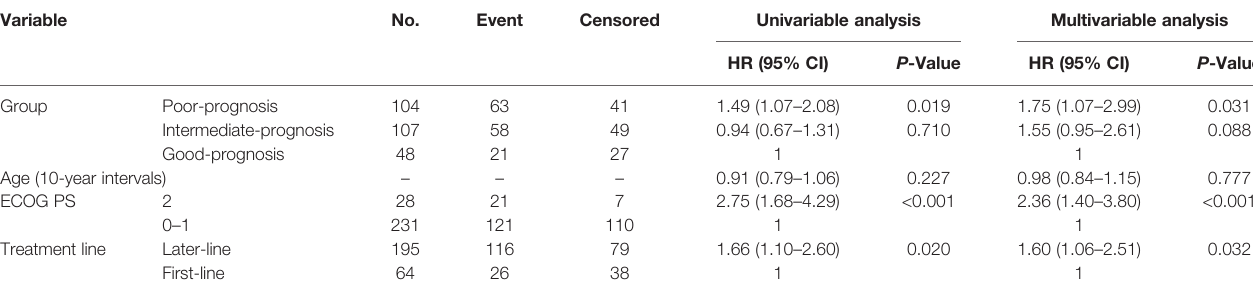
TABLE 4 | Univariable and multivariable Cox proportional hazard ratio of the prognostic score for overall survival.